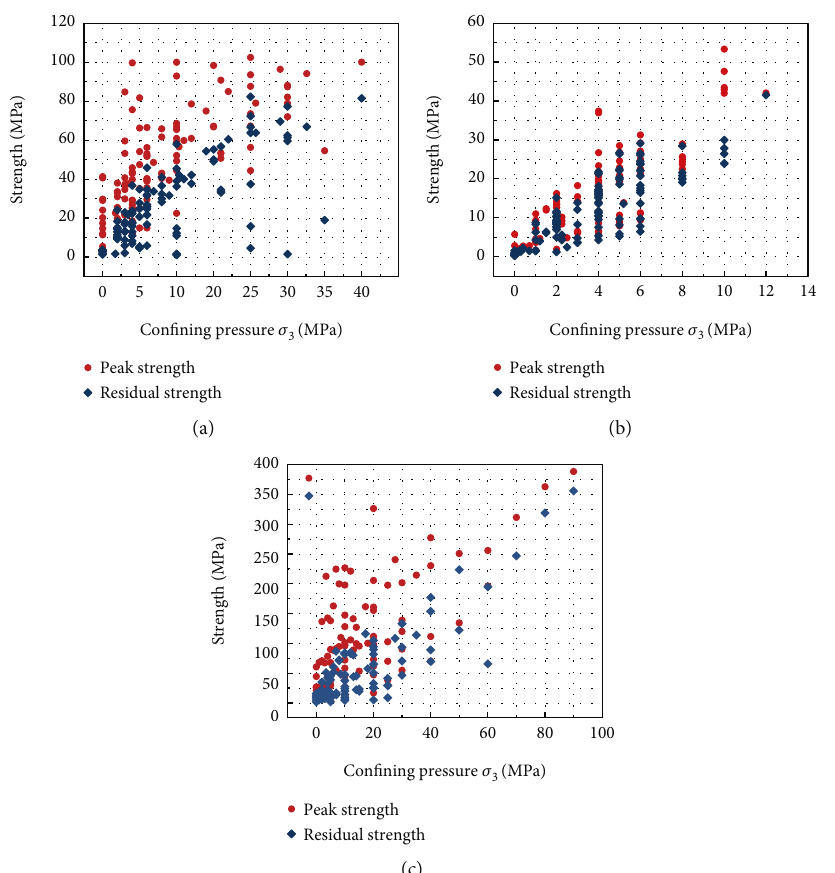
Figure 7: Comparative analysis of peak strength and residual strength with con fi ning pressure: (a) raw coal, (b) briquette composed of soft coal, and (c) soft rock.